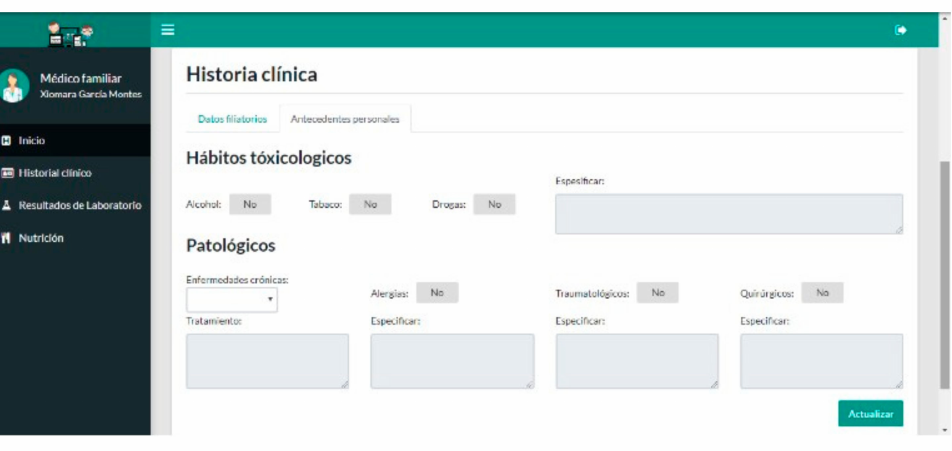
Figure 17. Physician application interface: The personal history section divided into harmful habits and pathological personal background.